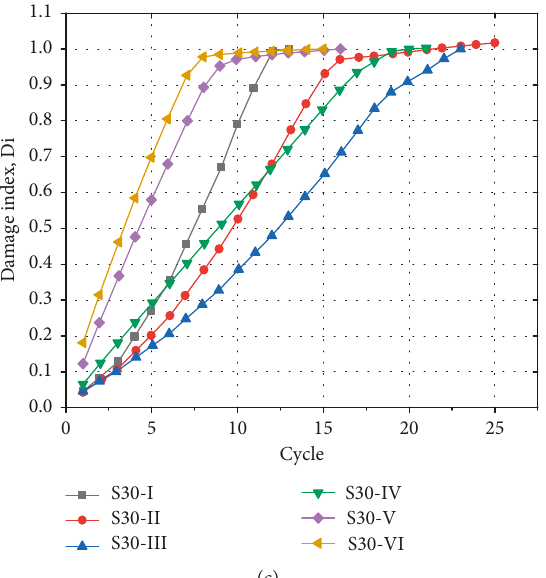
Figure 18: Damage index comparison. (a) Cumulative damage index of S24. (b) Cumulative damage index of S27. (c) Cumulative damage index of